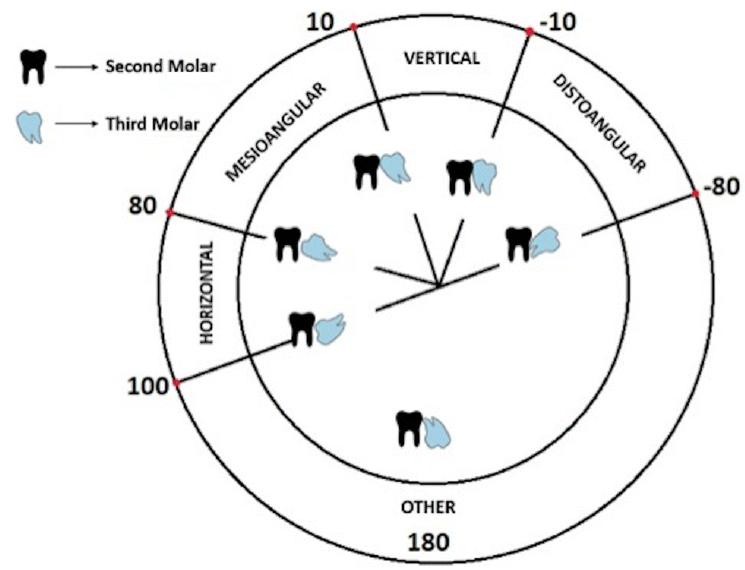
Figure 1. Winter’s mandibular third molar teeth classification scheme [34].